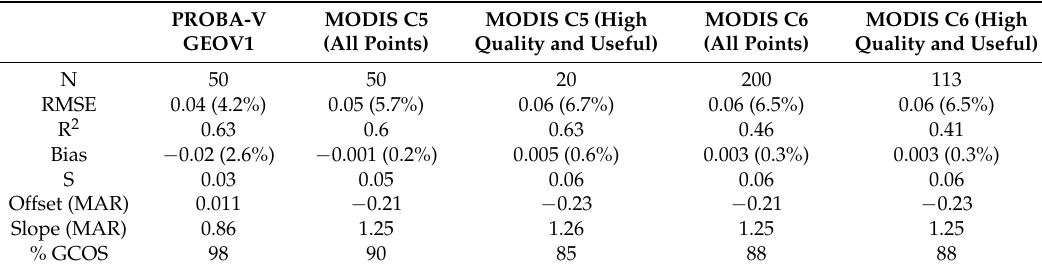
Table 6. Performance metrics of each green fAPAR satellite product versus ground-based canopy fAPAR maps. For RMSE and Bias (negative value means underestimation of the satellite product and vice versa), the relative values are displayed in brackets.